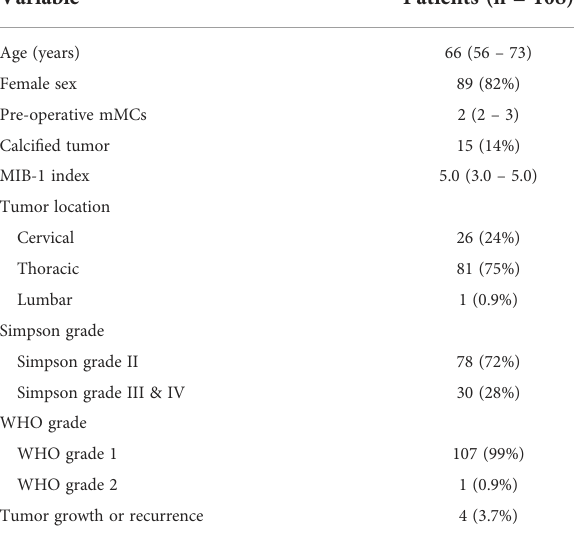
TABLE 2 Patient